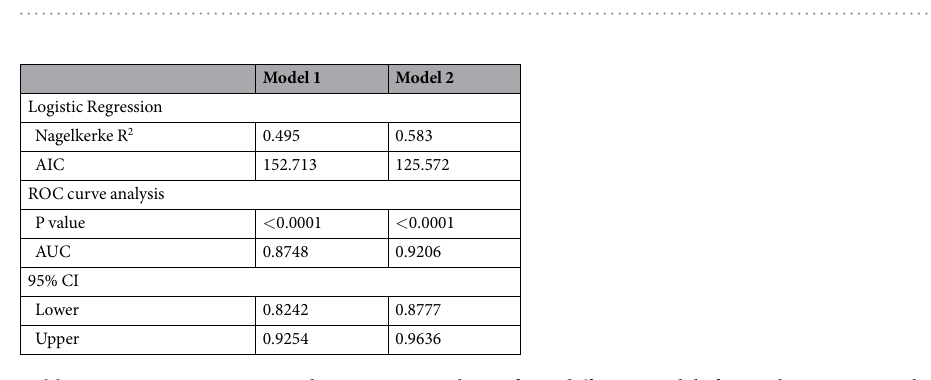
Figure 3. ROC curve analysis of the F-V ratio for predicting hemorrhagic MMD or MMS. ROC curve analysis of F-V ratio for predicting hemorrhagic MMD or MMS shows that the best cut-off point for predicting hemorrhagic MMD or MMS is 0.4344 (sensitivity = 81.4%, specificity = 73.2%, AUC = 0.8016), according to Youden’s index.